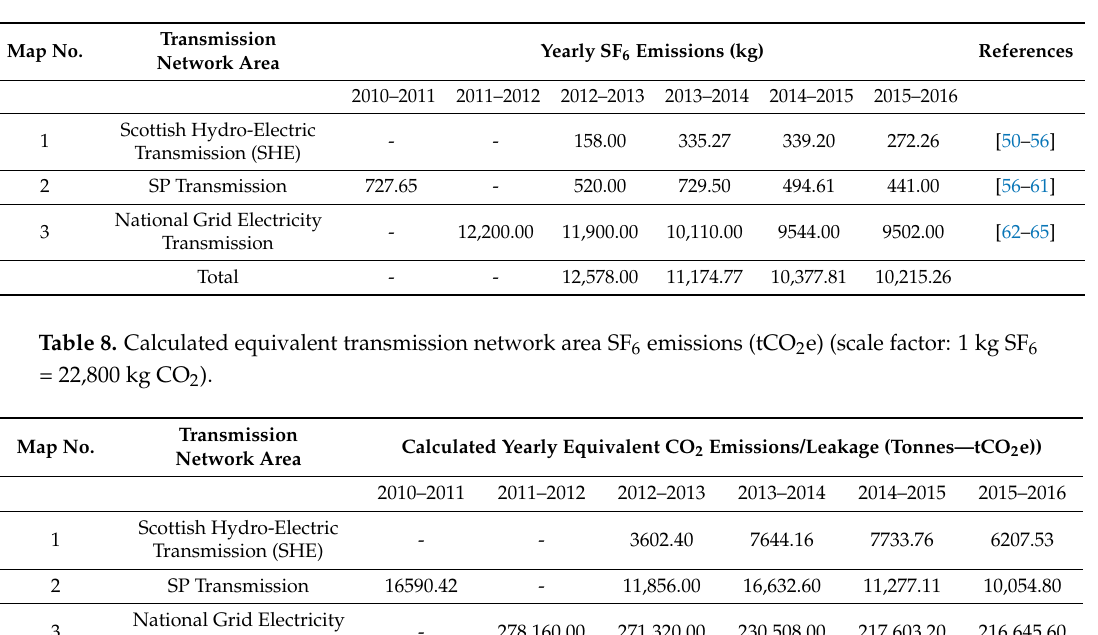
Table 7. SF 6 emissions (kg) by transmission network area in Great Britain.